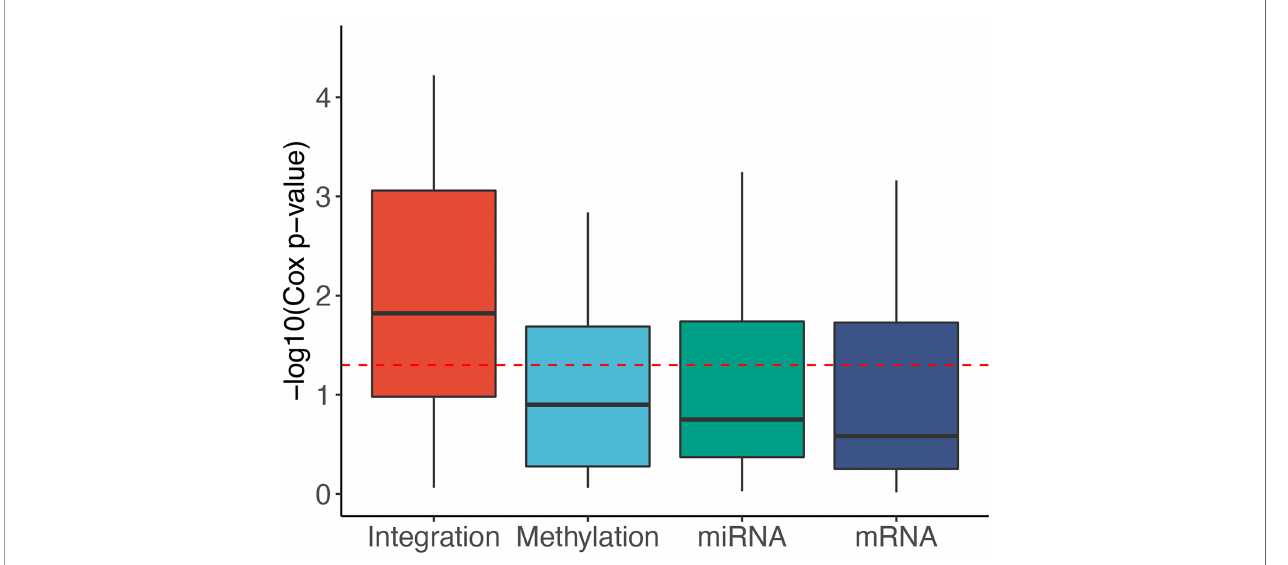
FIGURE 3 | Distribution of -log10 Cox p-values for each data type of the 37 TCGA datasets. The horizontal red line indicates the signi fi cant threshold of p -value = 0.05. The p-values of subtypes discovered using multi-omics integration are substantially more signi fi cant than those obtained from individual data types (mRNA, methylation,